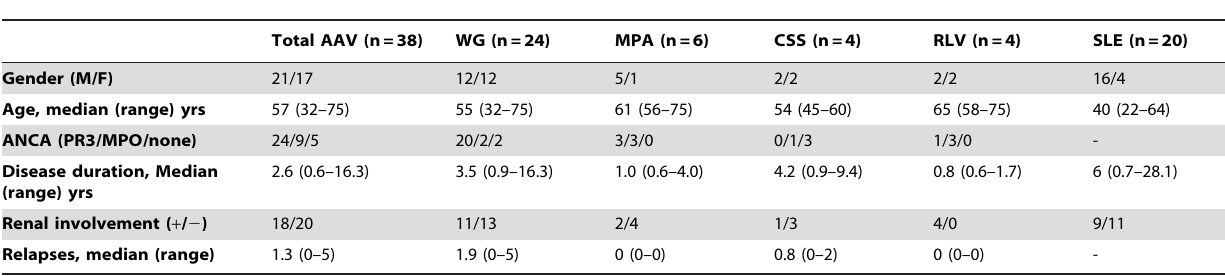
Table 1. Clinical characteristics of AAV*